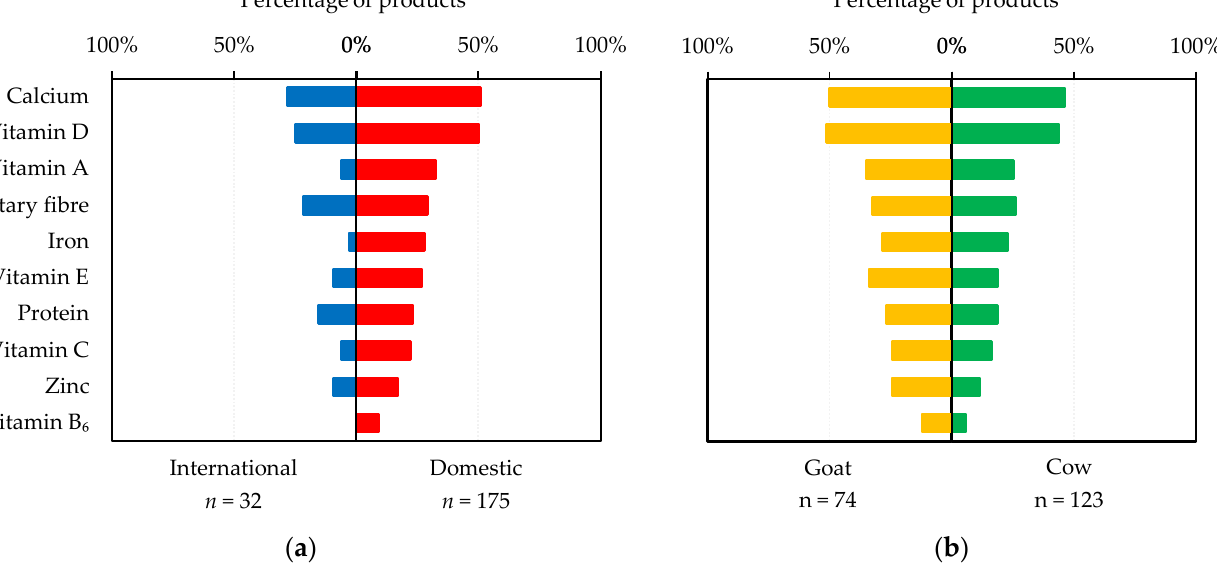
Figure 5. Percentage of milks targeting Chinese older adults made specific nutrient function claims that appeared on at least 5% of all products: ( a ) international brands vs. domestic brands; ( b ) goat milks vs. cow milks.